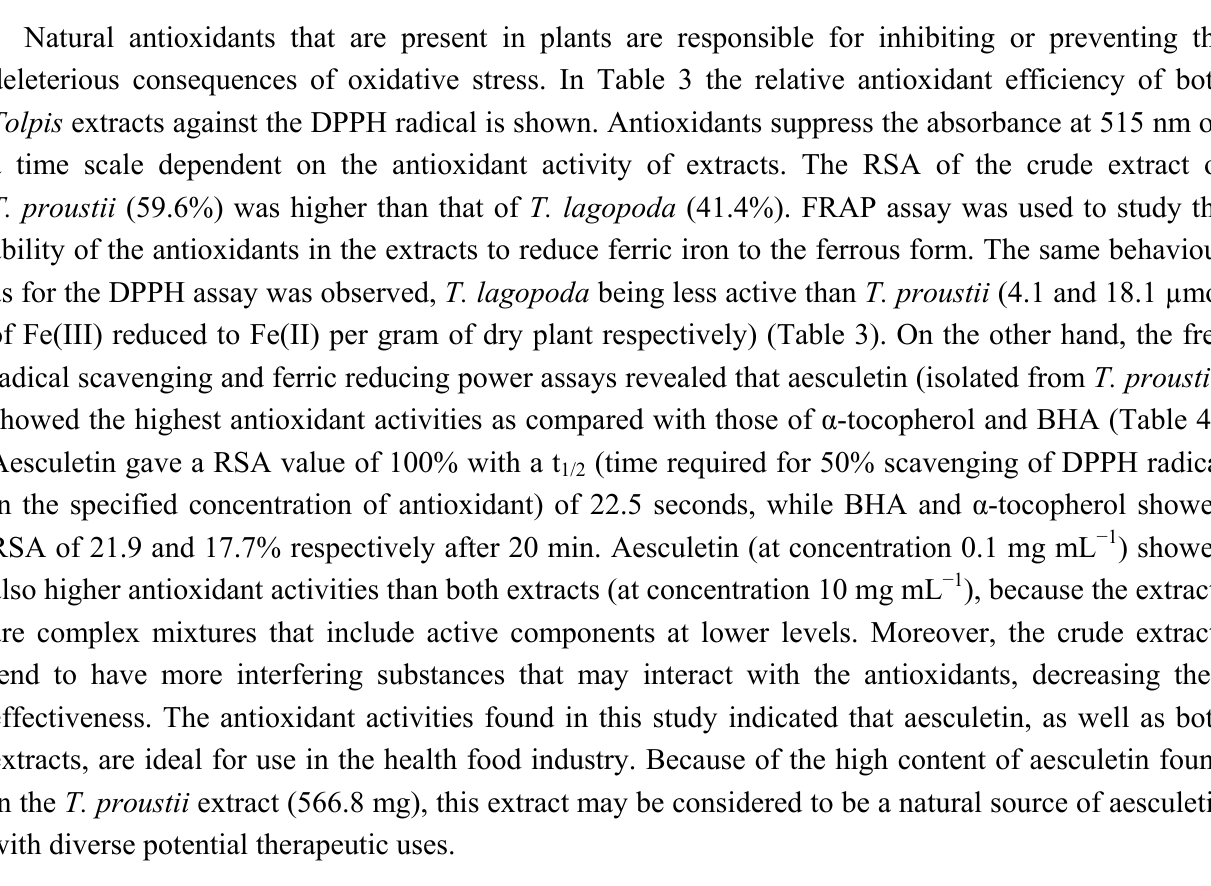
Table 3. Antioxidant activity of crude extracts derived from T. proustii and T. lagopoda .